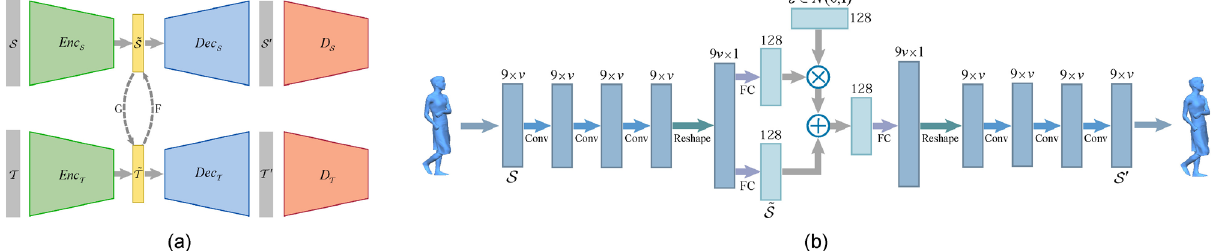
Fig. 6 Automatic unpaired shape deformation transfer. (a) Architecture of the proposed VC-GAN network for deformation transfer. (b) Convolutional variational autoencoder. Reproduced with permission from Ref. [82], c (cid:2) Association for Computing Machinery